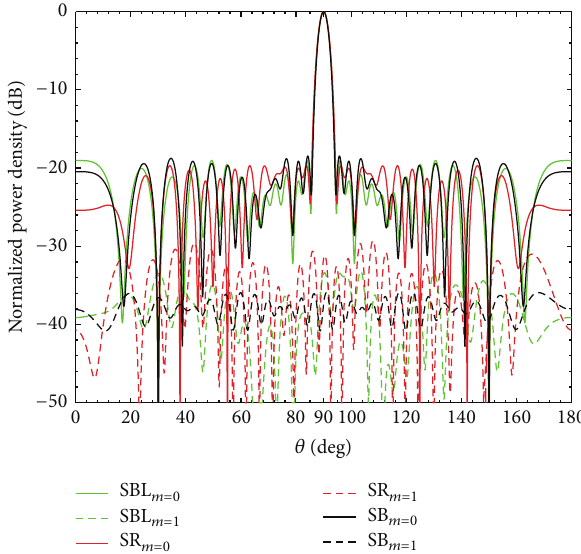
Figure 20: Radiation patterns at carrier frequency and at first harmonic related to Figure 19 for JSCIS.